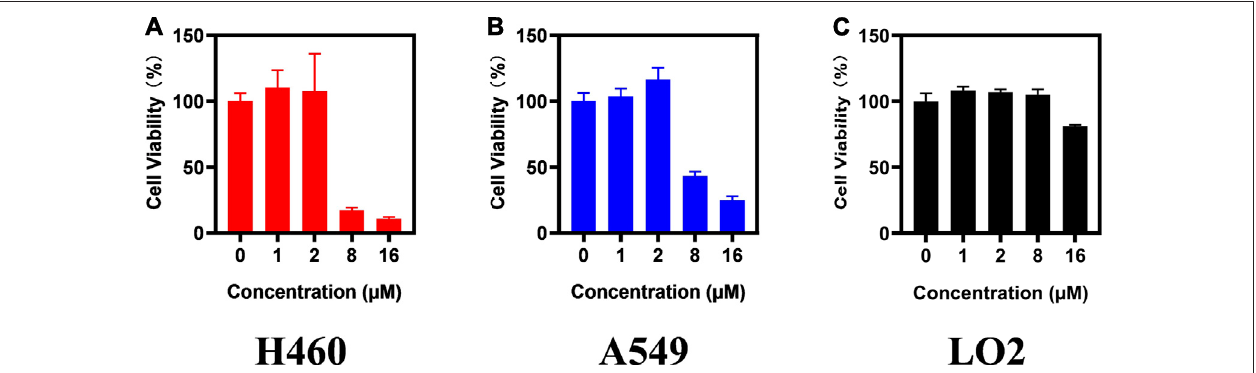
FIGURE 2 | Compound d17 supresses H460 and A549 cancer cells. H460 (A) , A549 (B), and LO2 (C) cells were exposed to compound d17 with indicated concentrations for72 h, and cell viabilitywasassessed bytheCCK-8assay, n (cid:1) 3.* p -value < 0.05,** p -value < 0.01, and *** p -value < 0.001(one-way ANOVA, followed by Tukey ’ s post-test).